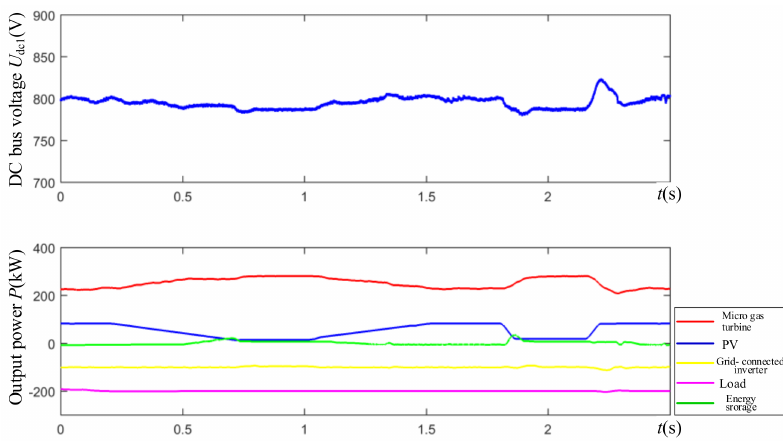
Figure 11. System response with improved droop